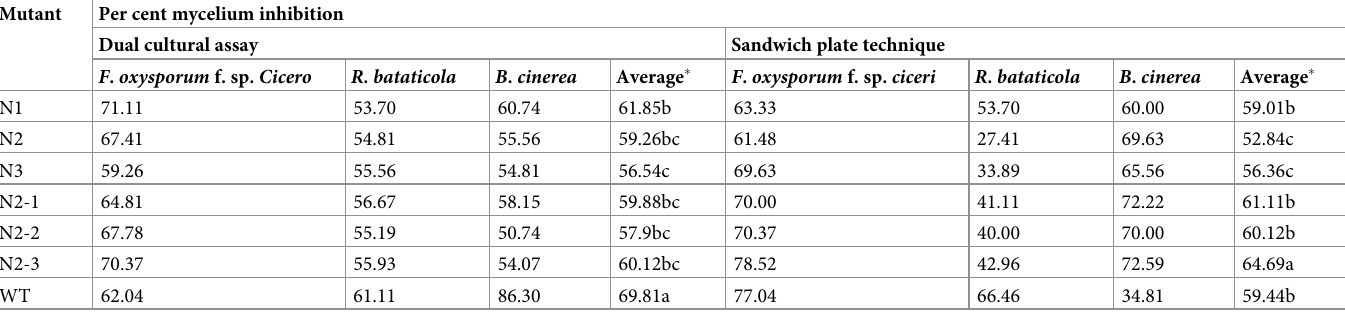
Table 2. Evaluation of antagonistic and diffusible volatile compounds inhibition ability of NTG induced Trichoderma mutants against chickpea pathogens. Mutant Per cent mycelium inhibition Dual cultural assay Sandwich plate technique F . oxysporum f. sp. Cicero